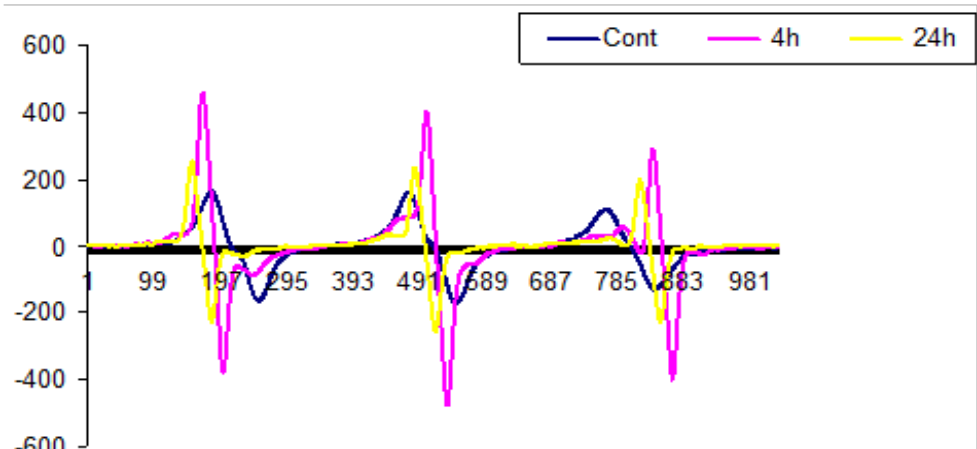
Figure 1. Electron spin resonance (ESR) spectra produced from Caco-2 cells incubated for 0, 4 or 24 h with 100 µ g / mL (24 h) UV-radiated methyl linoleate. The spectra were recorded with a modulation of 100 kHz, 5 mW microwave power, a central magnetic field of 328.5 G and a scan of 200 and 4 G at room temperature.